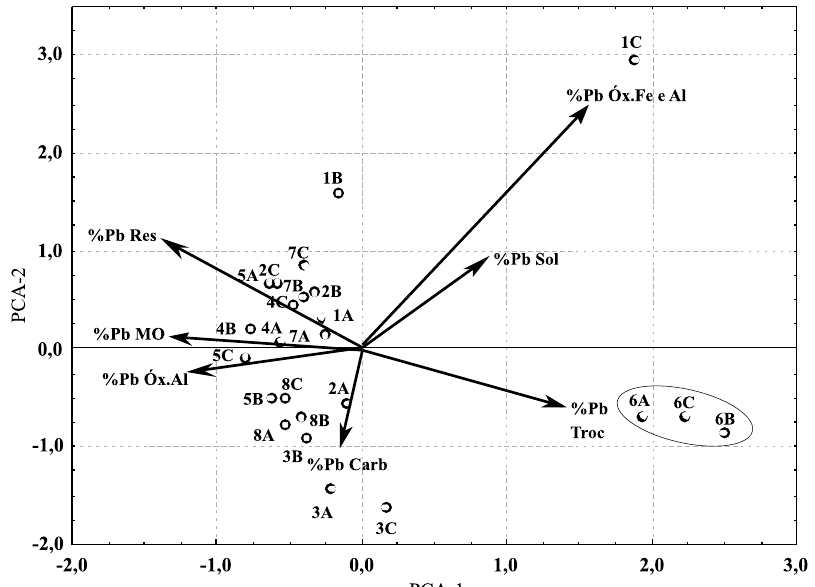
Figura 2. Gráfico dos componentes principais (PCA-1 e PCA-2) das amostras e da distribuição percentual do Pb total em cada fração da análise sequencial: Sol.: solúvel; Troc.: trocável; Carb: carbonatos; MO: matéria orgânica; Óx. Fe e Al: óxidos de F e Al amorfos; Óx. Al: óxidos de Al cristalinos e minerais secundários filossilicatados (1:1 e 2:1); Res: residual. NOTA: O número representa o ponto de coleta, e a letra, a profundidade. (A= 0 a 10 cm; B= 10 a 20 cm; C= 20 a 40